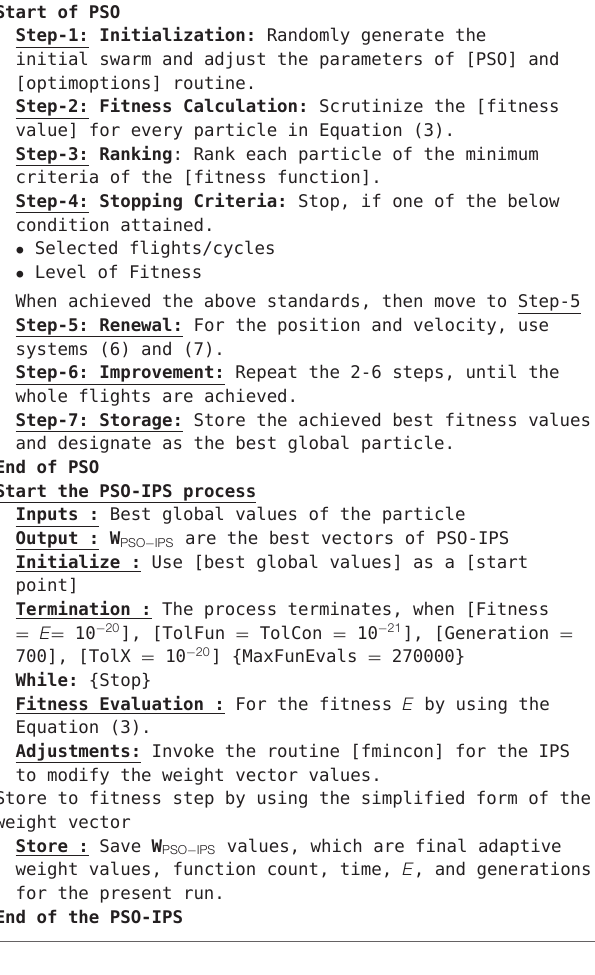
TABLE 1 | Pseudo code of the optimization tool PSO-IPS to find the weights of